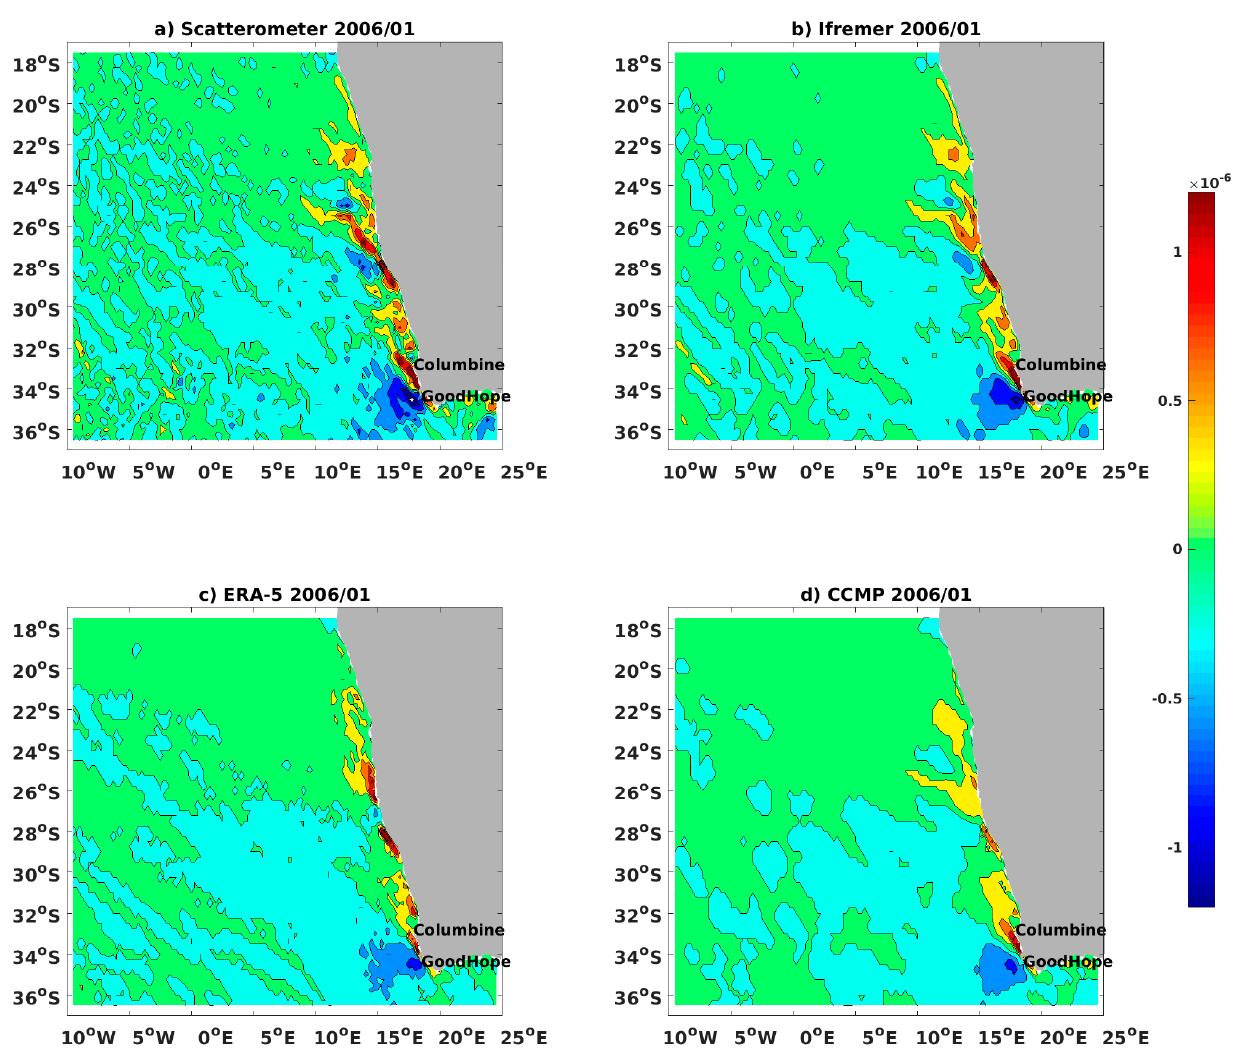
Figure 9. The same as in Figure 8 but over the Benguela zone in January 2006.